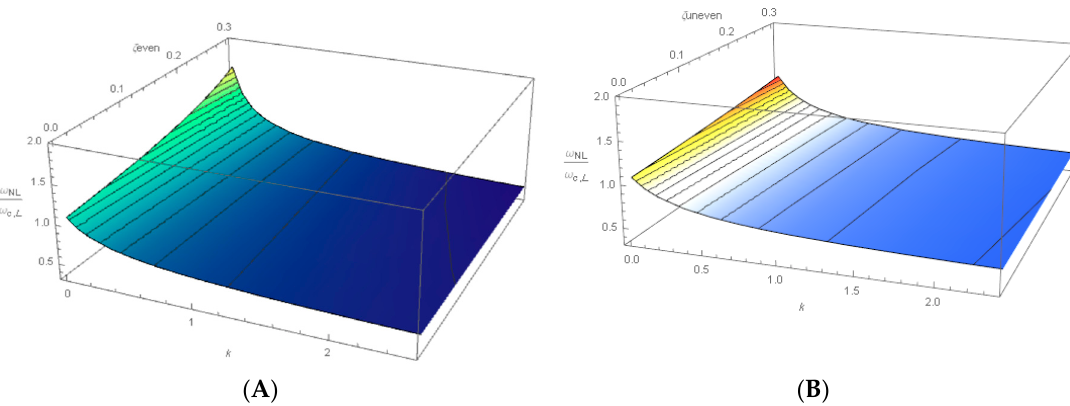
Figure 6. Simply-supported porous FG nano-beams: 3D-plot of the frequency ratio in terms of porosity volume fraction ( 𝜁 ) and gradient index ( 𝑘 ) with 𝒜 (cid:3050) = 0.2, 𝒜 (cid:2868) = 0.0 and 𝐾(cid:3561) (cid:3050) = 0: ( A ) even distribution of porosity, and ( B ) uneven distribution of porosity.